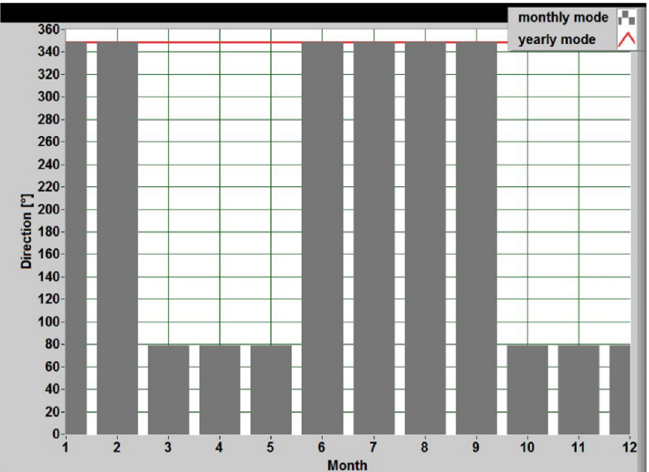
Figure 7. Monthly variation of the Molise wave climate directional mode.